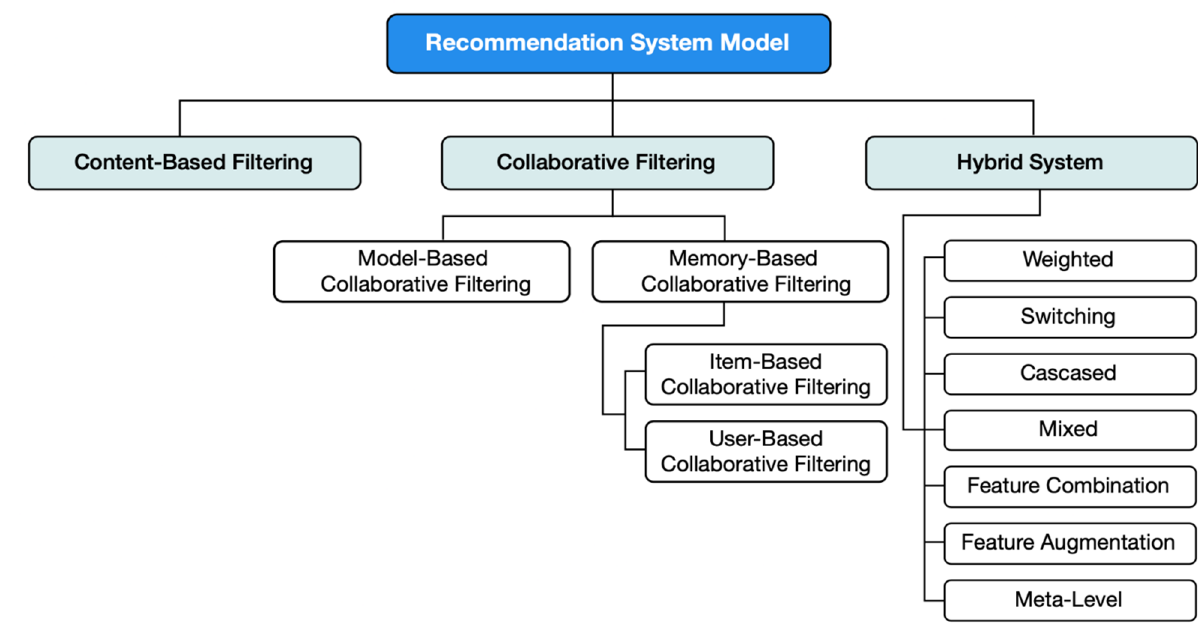
Figure 3. Overview of recommendation models.